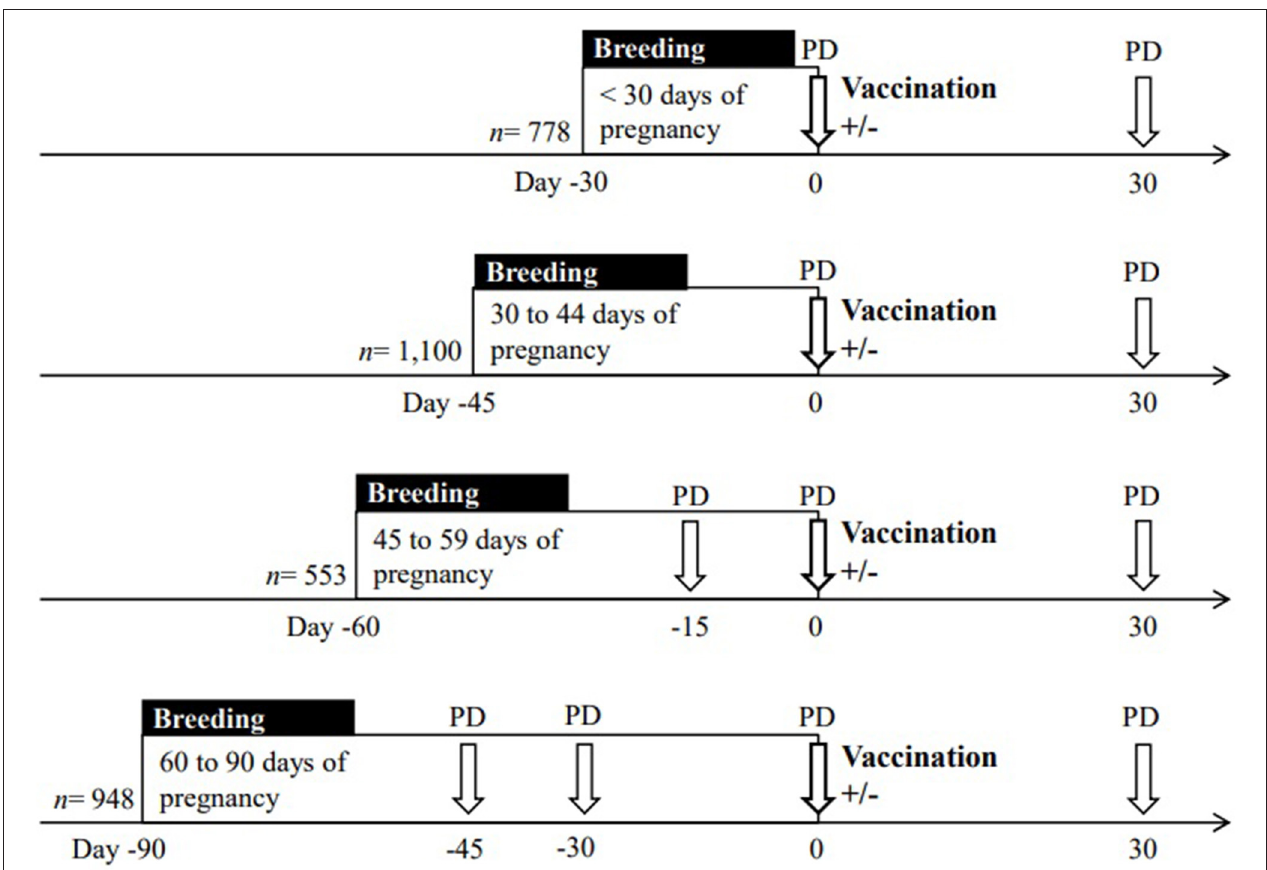
FIGURE 1 | Schematic representation of the experimental design to evaluate the effect of the vaccination (Day 0, n = 3,379) against foot-and-mouth disease (FMD) on pregnancy failure in beef cows. For each gestational age, breeding period includes natural service or insemination. The vaccine was administered ( + ) or not administered (–) at different gestational ages, which were determined by pregnancy diagnosis (PD) performed by ultrasound examination before the beginning of the experiment (i.e., from 30 to 45 days after mating/insemination). For determination of pregnancy failure, PD was repeated in all the cows on Day 0 and on Day 30 post